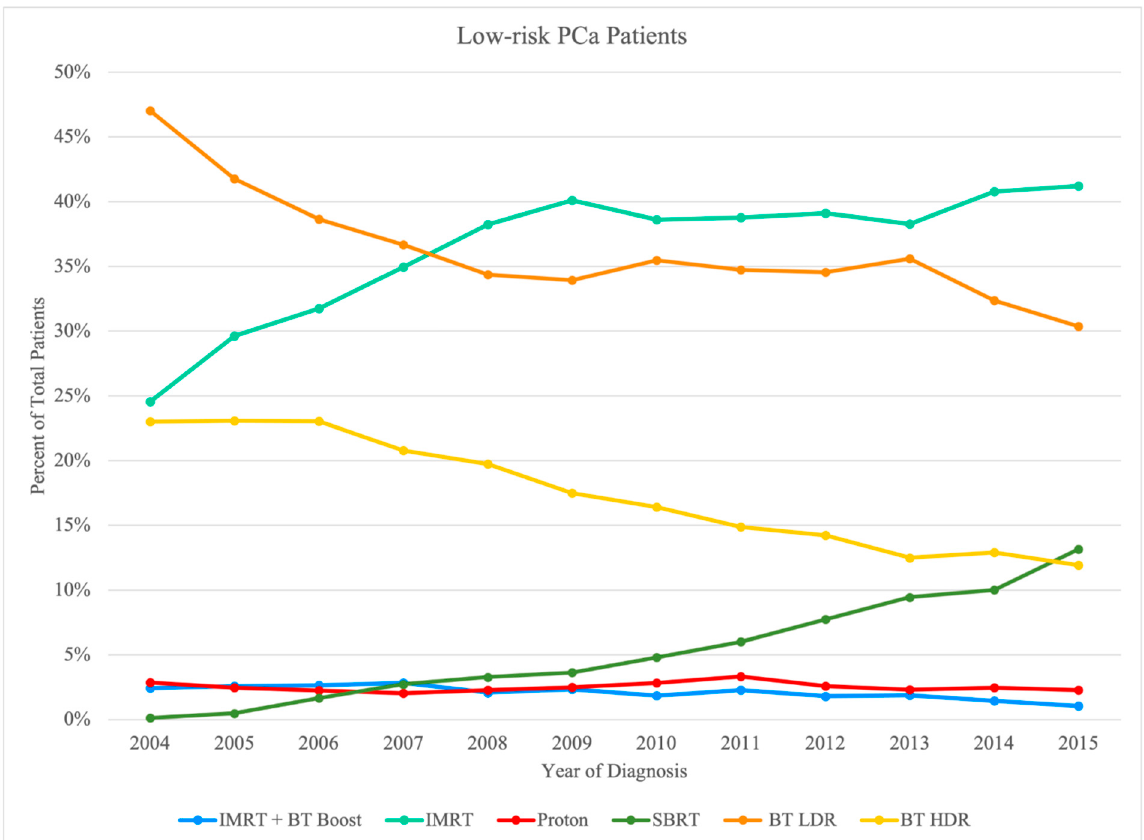
Figure 2. Pattern of utilization of radiation therapy modality for low-risk PCa by treatment modality.